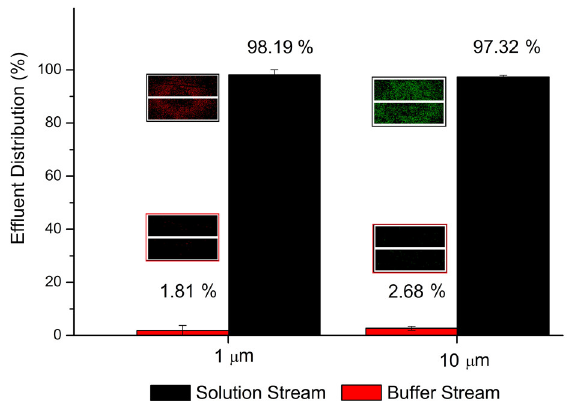
Figure 2. Percentage of micro-particles flowing out via two outlets. The insets are pictures of droplets from outflows under the microscope. The presented percentage is averaged from five tests.